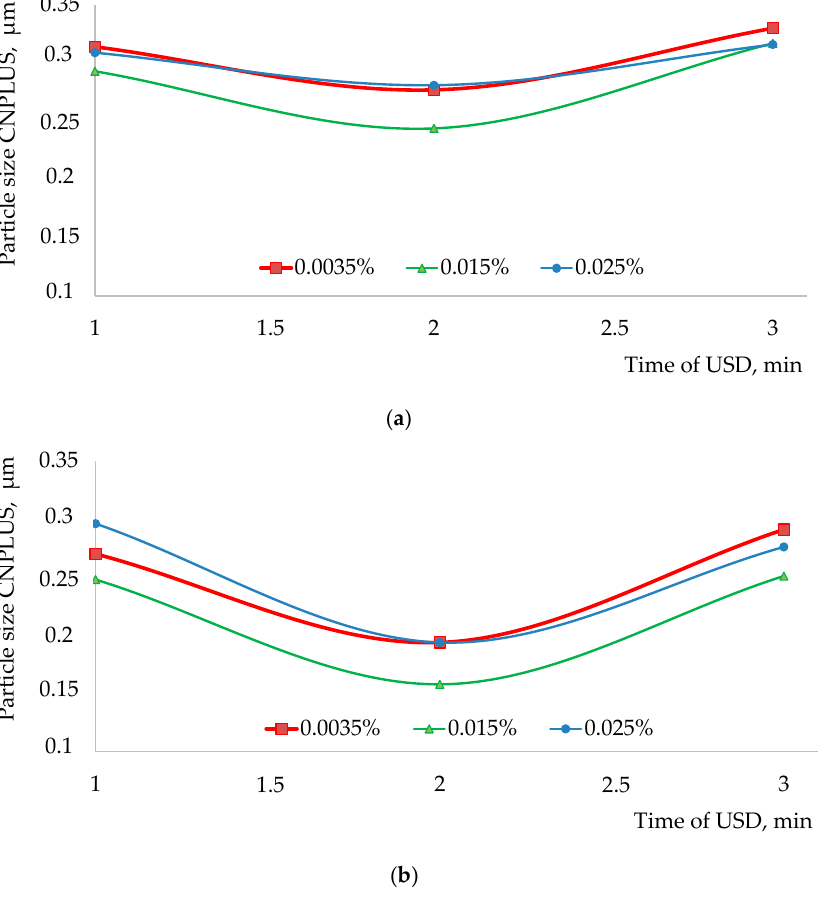
Table 4. Evaluation of applicability of Shishkovsky’s empirical equation for description of the im- pact of the ViscoCrete-2100 concentration on the surface tension of aqueous solutions. Surfactant’s Concentra- tion, %